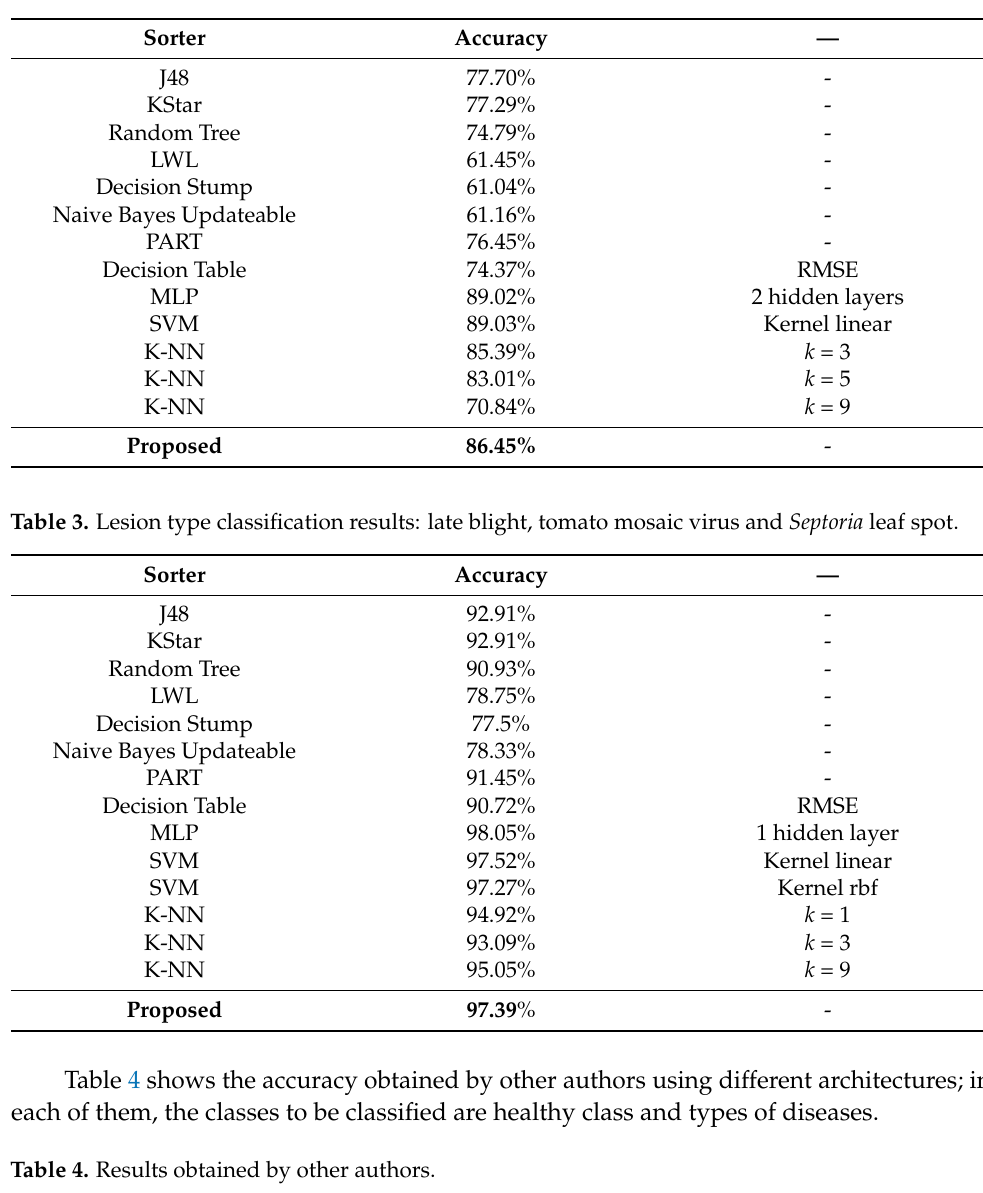
Table 2. Sorting results of healthy and sick tomato leaves.